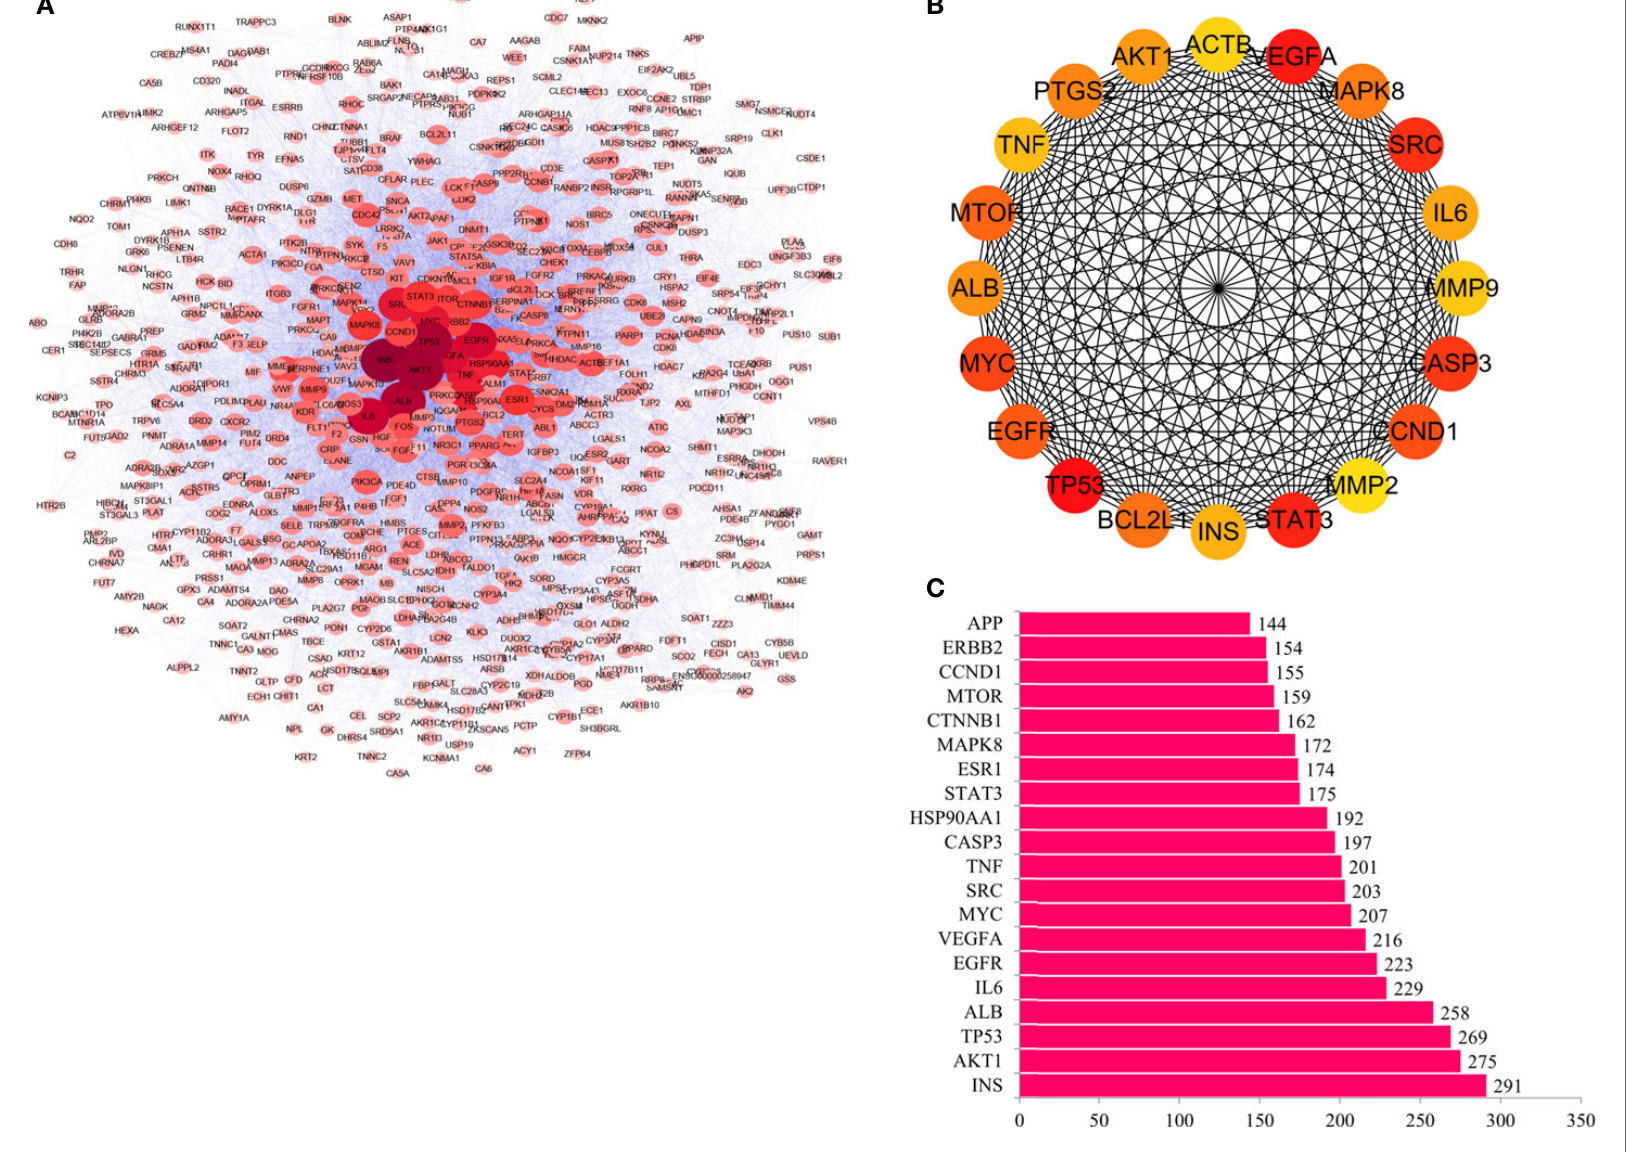
FIGURE 2 | PPI and hub genes of RPL against lung cancer. (A) Interaction between proteins. (B) Interaction between these genes. (C) Genes with highest node